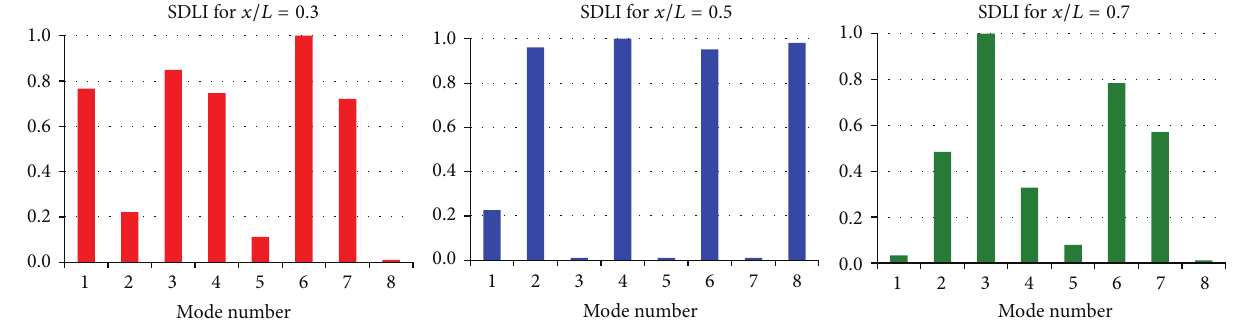
Figure 7: Damage location index for damage placed at 𝑥/𝐿 = 0.3 , 𝑥/𝐿 = 0.5 , and 𝑥/𝐿 = 0.7 , respectively.